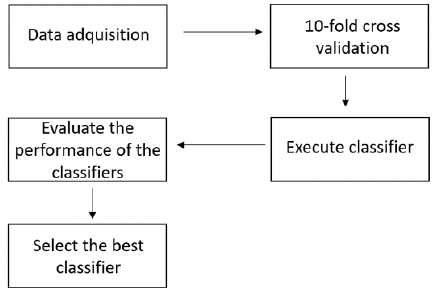
Figure 3. Selection process of the best